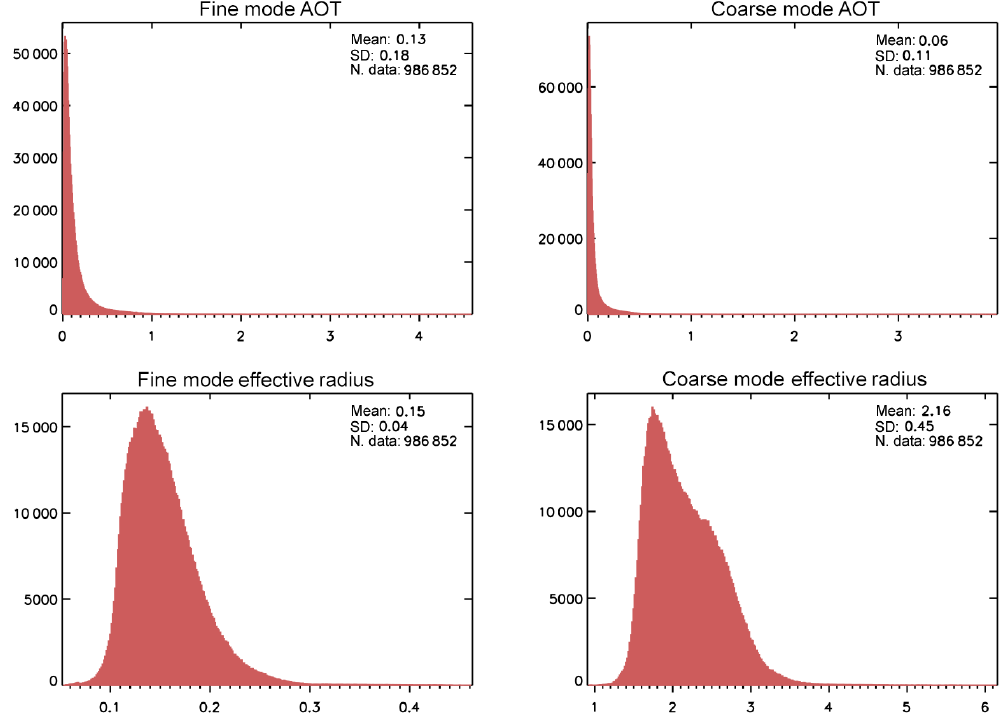
Figure 2. Histograms of the statistical distribution of fine- and coarse-mode AOT and effective radius used to generate the training data